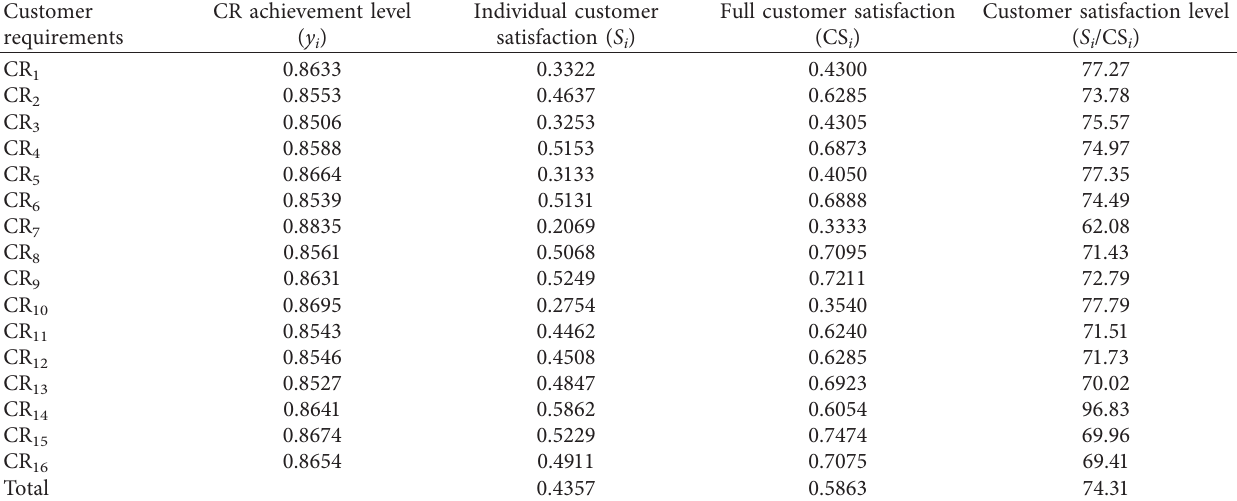
Table 10: Satisfaction level and customer satisfaction of customer requirement.